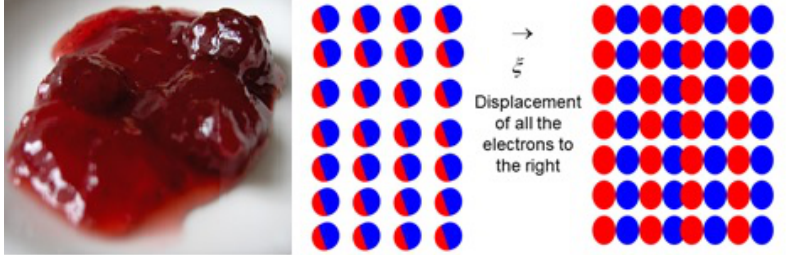
Figure 2. The ‘jellium model’ considers the collection of positive nuclear charges and negative electron charges smeared out uniformly across the region of a metal; the centers of positive and negative charges being coincident. A slight relative displacement of the centers of positive and negative parts of the total charge density sets in plasma